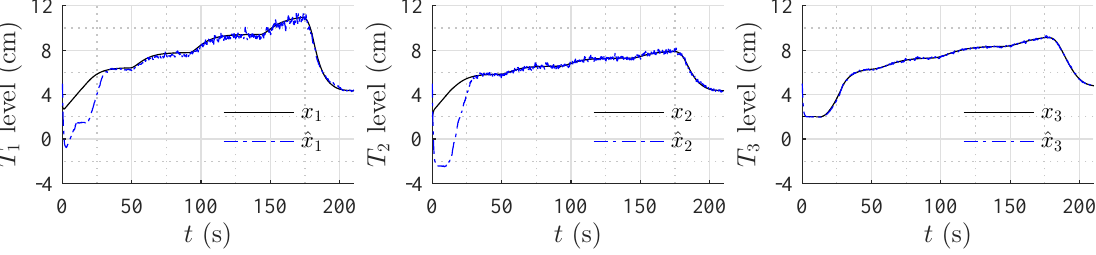
Figure 6. Simulation with rectangular weir at T 2 and linear weir at T 3 .